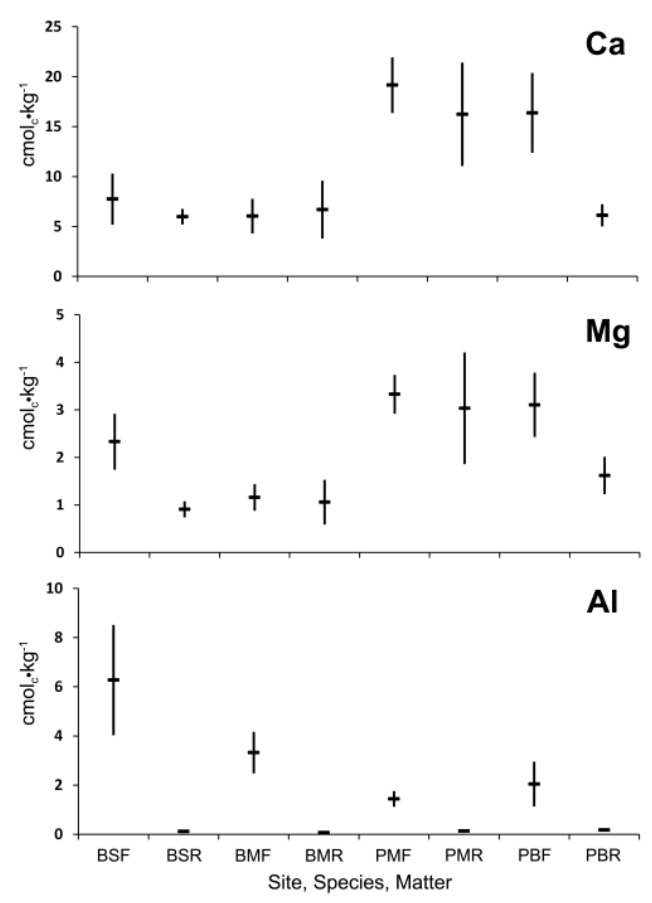
Figure 6. Comparison of mean concentration of exchangeable Ca, Mg, and Al and 95% confidence interval ( n = 20) for the lower forest floor (F) and decayed wood (R) or red spruce (S), red maple (M), and paper birch (B) at the Bartlett Experimental Forest (B) or the Penobscot Experimental Forest (P) after 10 years of decay with ground